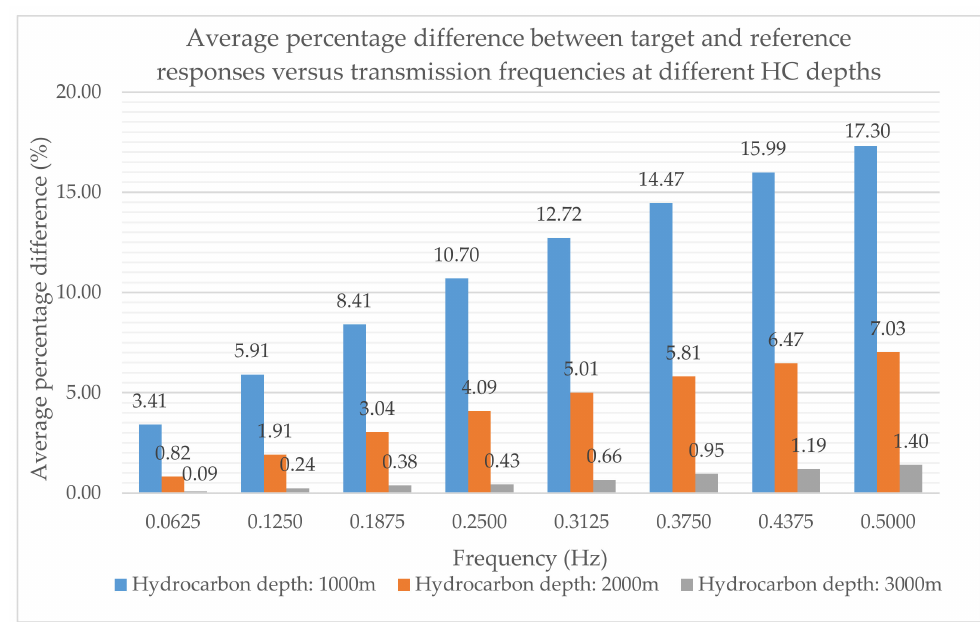
Figure 9. Histogram of the average percentage di ff erence between the target EM responses and the reference responses. There were three histograms which represented the depths of hydrocarbon. The average percentage di ff erence was calculated for every transmission frequency used in this research